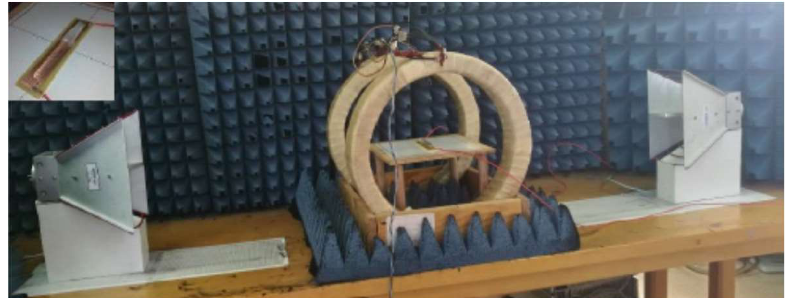
Figure 2. Experimental set-up for frequency and time domain measurements including emitting and receiving antennas, Helmholtz coils and detail of magnetic microwire inside of a capillary on a heating resistance. Insert: Detail of magnetic microwire inside of a capillary on a heating resistance.